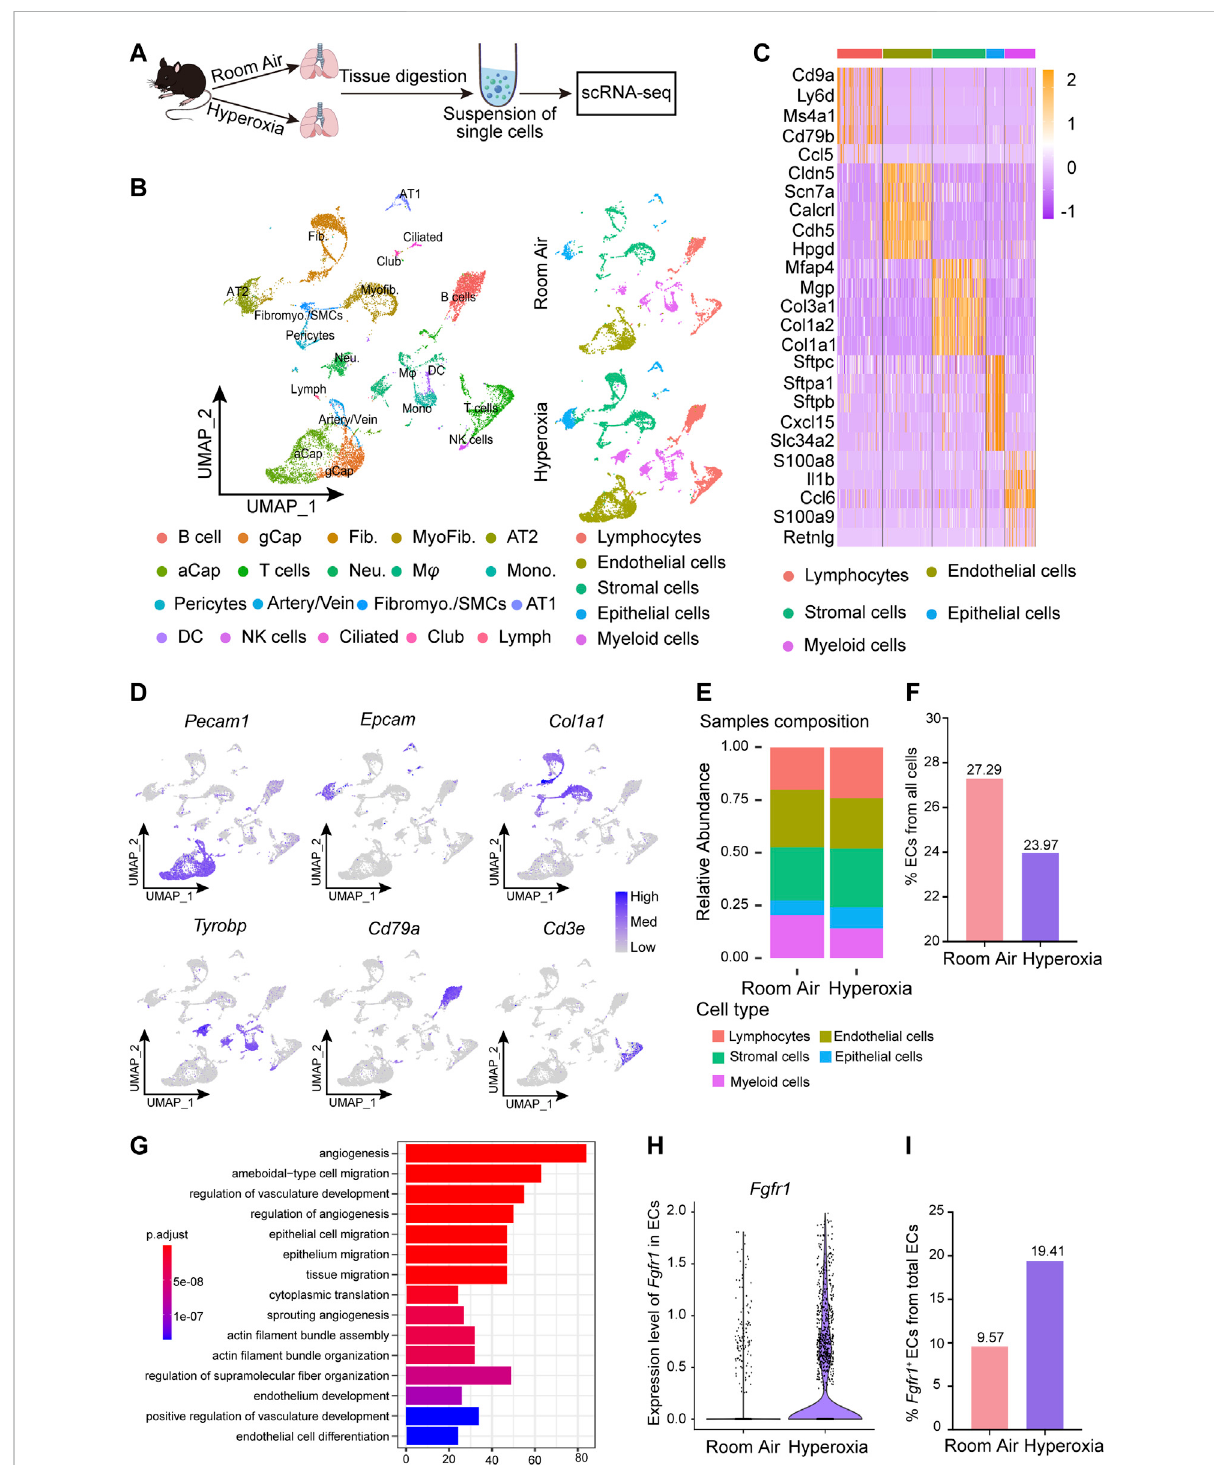
scRNA-seq analysis of lungs from normoxia- and hyperoxia-reared mice. (A) Approach to generate a single-cell atlas. (B) UMAP plot of all scRNA-seq data, showing a total of 19 distinct cell types corresponding to 5 major cell groups. Cell populations are colored as indicated by the legend. (C) Heatmapofthetop5mostdifferentiallyexpressedgenesacross5majorcelltypes.Theintensity ofexpressionisindicatedasspeci fi edby thecolorlegend. (D) Featureplotsshowingtheexpressionofprincipalidenti fi ersofepithelialcells,endothelialcells,stromalcells,myeloidcells, lymphocytes(Bcells)andlymphocyte(Tcells)populations. (E) Cellularcompositionsarecoloredasindicatedbythelegendinnormalandhyperoxia-